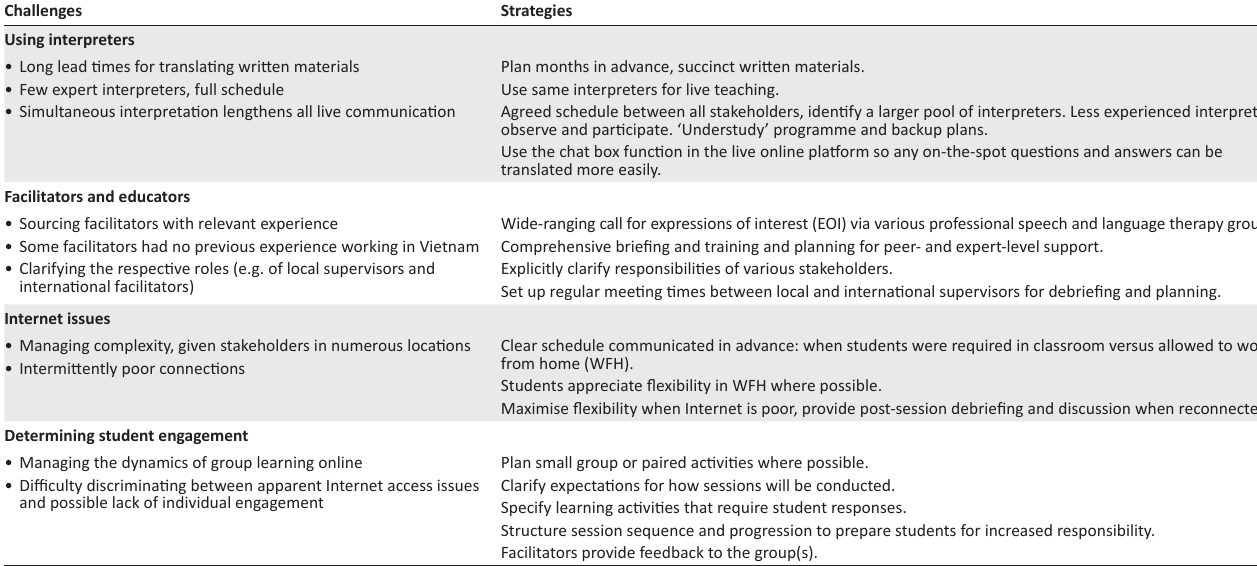
TABLE 1: Challenges encountered and strategies